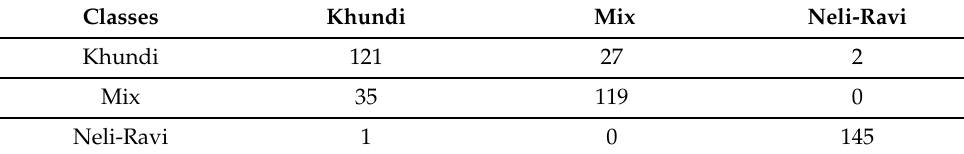
Table 14. Confusion matrix obtained using SVM on 10-fold cross validation